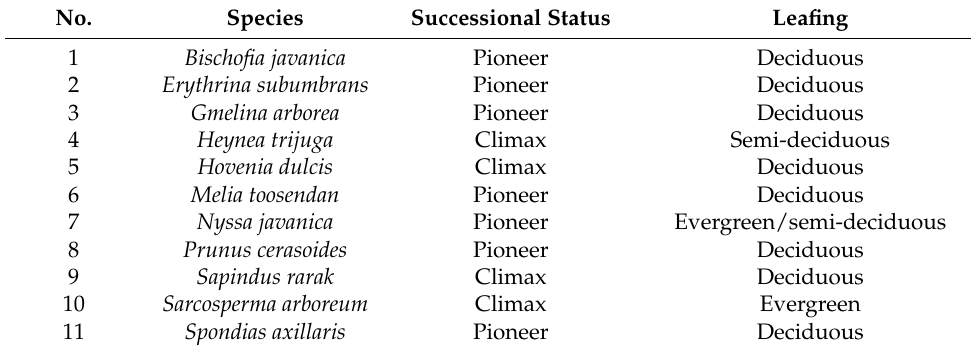
Table 1. Tree species included in this